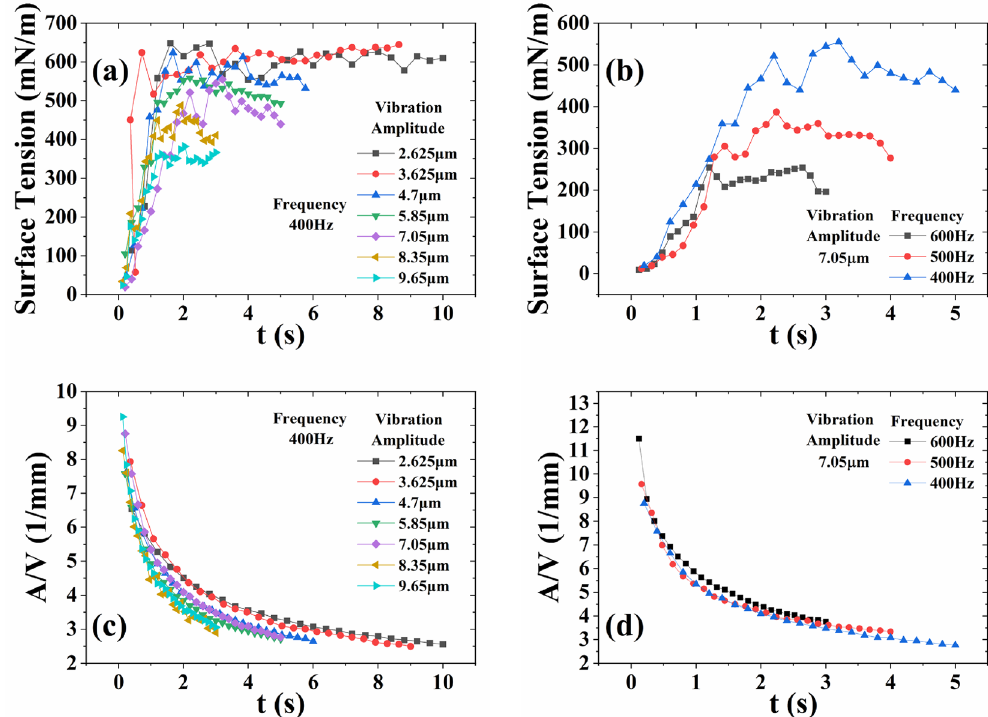
Figure 5. Surface tension and Moldability. ( a ) Influence of vibration amplitude on the surface tension of droplets. ( b ) Influence of vibration frequency on the surface tension of droplets. ( c ) Influence of vibration amplitude on the moldability of droplets. ( d ) Influence of vibration frequency on the moldability of droplets. In the experiment, the weight of the EGaIn in the syringe is 50